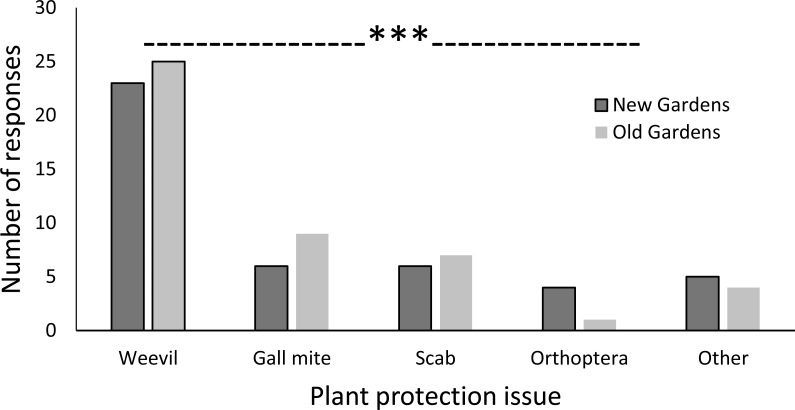
Plant protection issues cited in the top three concerns by farmers’ for pest and disease problems.Means are the number of farmers mentioning a given concern and are non-mutually exclusive, some farmers mentioning one, and some up to three issues. (Chi-square test compared pest types within each garden age: new gardens, priority is used by times been listed without giving any points. Weevil: X2 = 16.448, df = 4, p = 0.002; old gardens, X2 = 23.836, df = 4, p < 0.001).